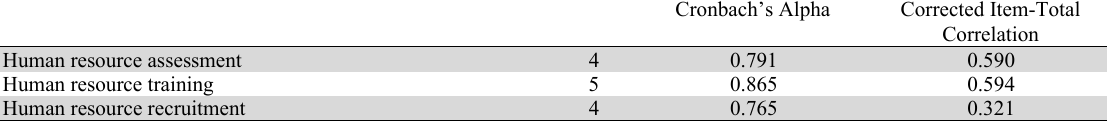
Results of analysis of Determinants Confidence of Scales in the